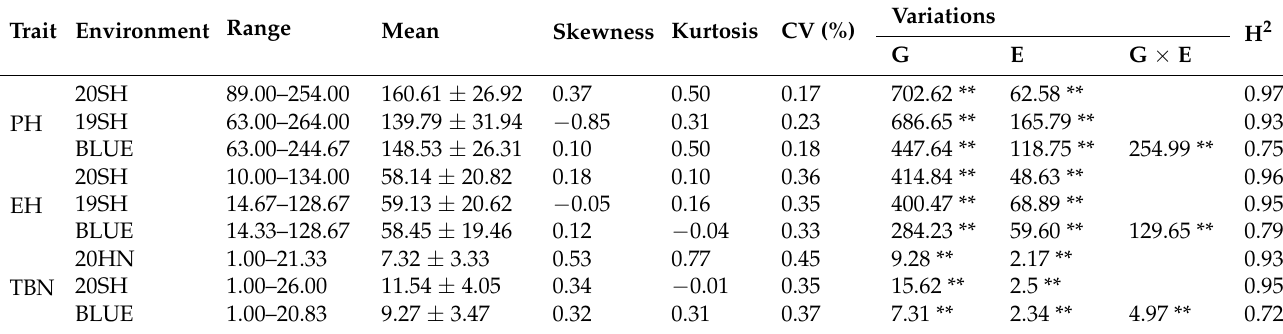
Table 1. Descriptive statistics, variance components, and broad-sense heritability (H 2 ) response to PH, EH, TBN in the